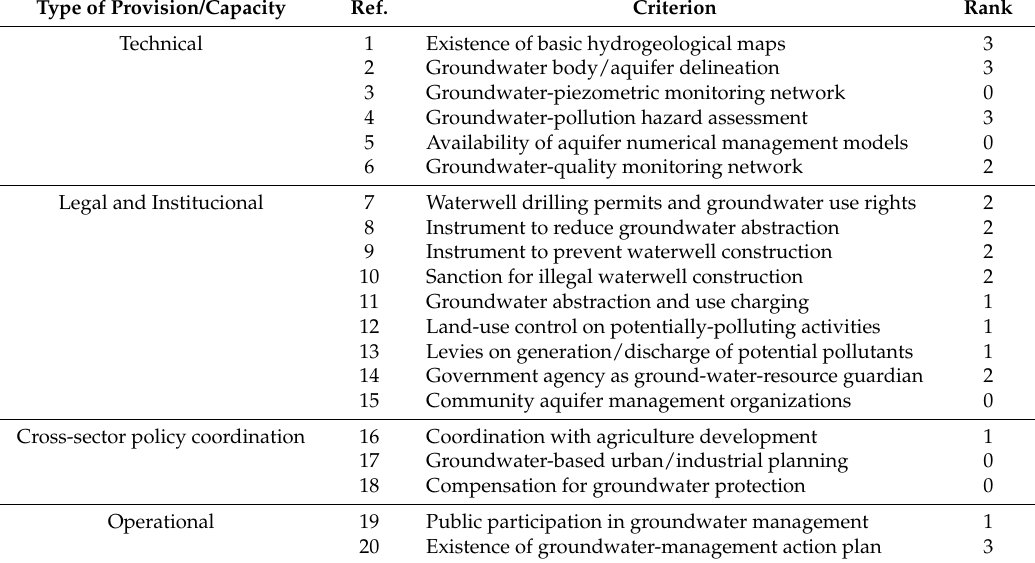
Table 3. Check-list of benchmarking criteria to evaluate groundwater governance in the Azores (0: non-existent; 1: incipient; 2: acceptable; 3: optimum) (criteria according to [1,80]). Type of Provision/Capacity